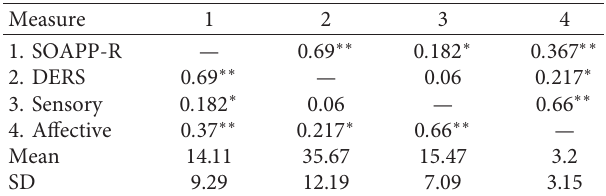
Table 2: Summary of correlations, means, and standard deviations for main variables of interest.